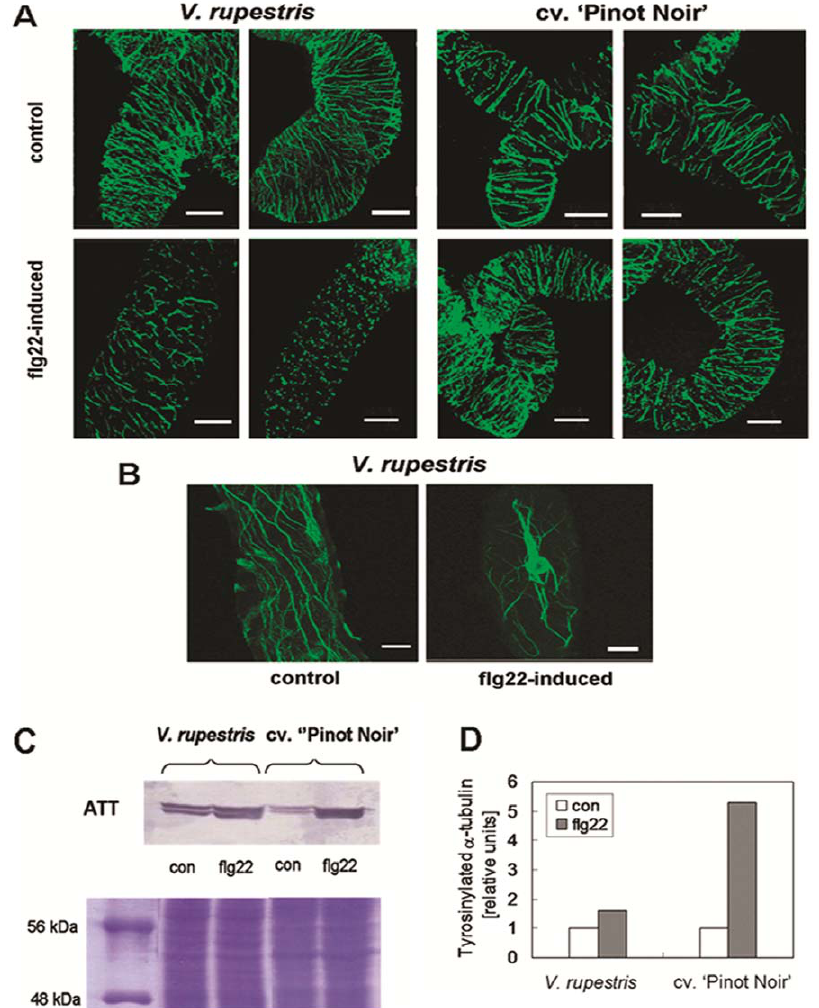
Figure 6. Response of the cytoskeleton to flg22. A Disintegration of microtubules visualised by immunofluorescence1 h after addition of 1 m M flg22 or water as negative control. Size bar 20 m m. B Reorganisation of actin filaments visualised by FITC-phalloidin upon flg22 treatment as compared to the water control. Representative geometrical projections from Apotome Z-stacks collected from control (left) or after 3 h (flg22- induced, right) of treatment with 1 m M flg22 are shown. Size bar 20 m m. C Abundance of tyrosinylated a -tubulin in total extracts 24 h after additioin of 1 m M flg22 visualised by Western blotting probing with specific monoclonal antibodies. The same amount of total protein was loaded in each lane, verified by staining of a replicate by Coomassie Brilliant Blue. D Relative abundance of tyrosinylated a -tubulin quantified for the flg22 treatment (flg22, grey bars) as compared to control (con, white bars).